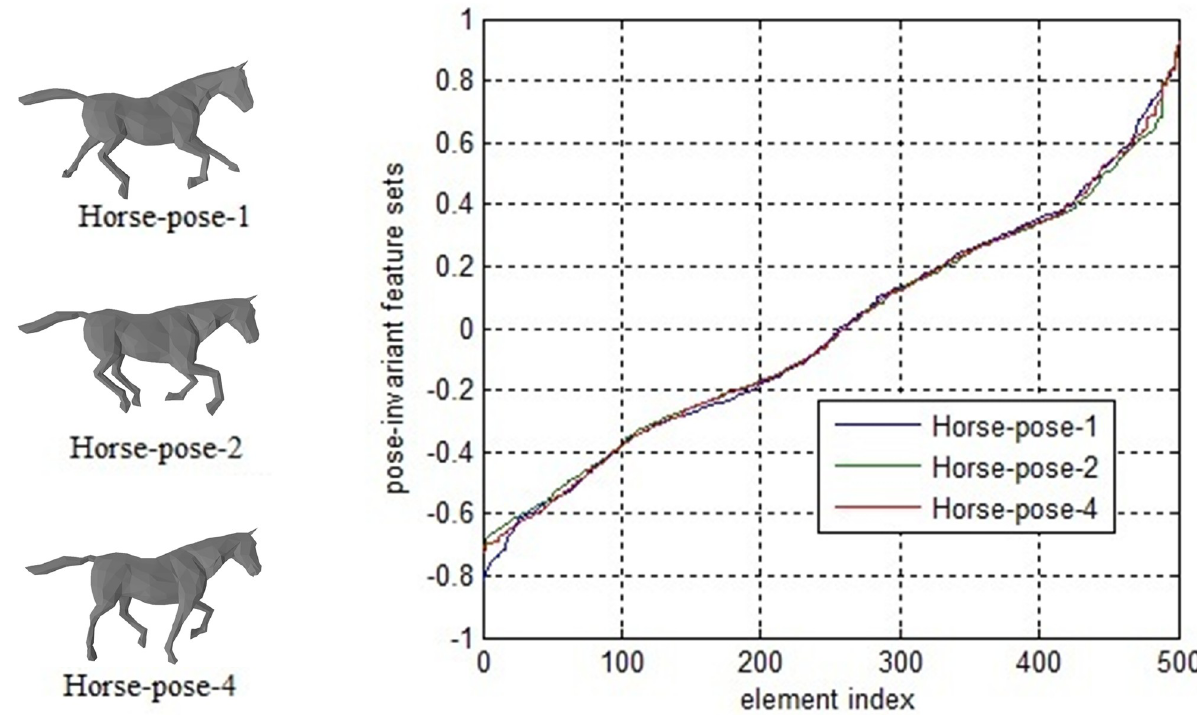
Fig 3. Our pose-invariant feature sets for 3 horse models with different poses. The feature set is defined in Section 3.4. The horizontal axis represents the i th element in each feature set. The vertical axis represents the corresponding z